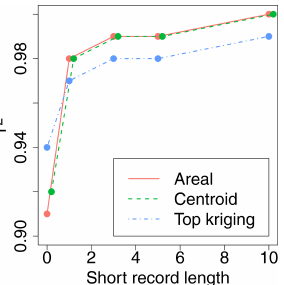
Figure 15. The squared correlation coefficient ( r 2 ) for predictions of mean annual runoff for catchments in Norway with record length 0, 1, 3, 5 and